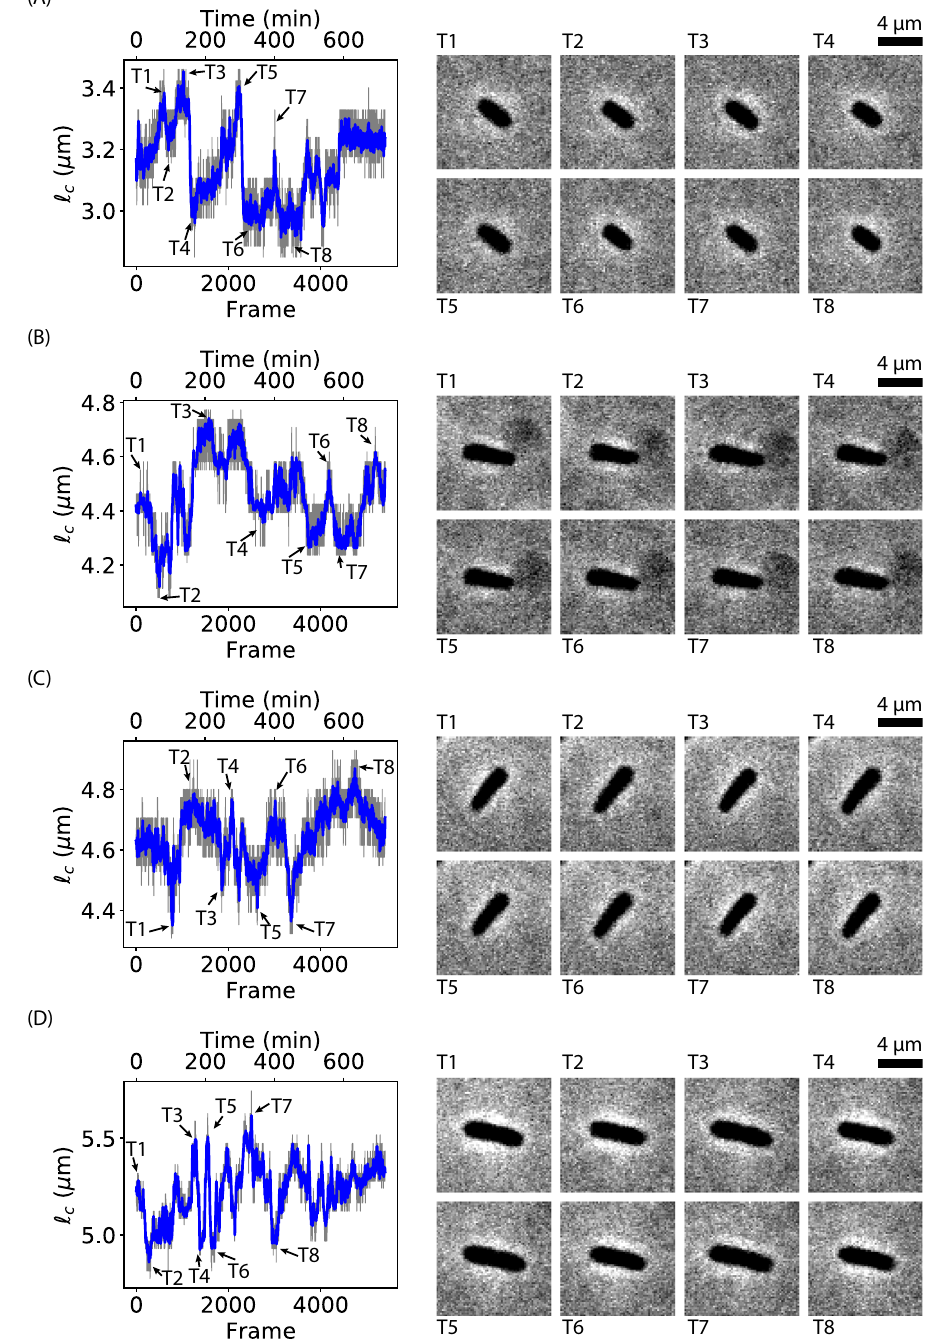
Figure 1. Oscillation in cell-length. ( A–D ) Cell-length as a function of frame number (time) from four examples of oscillatory bacteria in the presence of Ag + ions. Representative peaks and valleys in the fluctuations were labeled by arrows and numbered as T1, T2, … , and T8. Images of the bacteria in the frames { T i } are shown in the right panels, extracted from ( A ) SI Movie M4, ( B ) SI Movie M5, ( C ) SI Movie M6, and ( D ) SI Movie